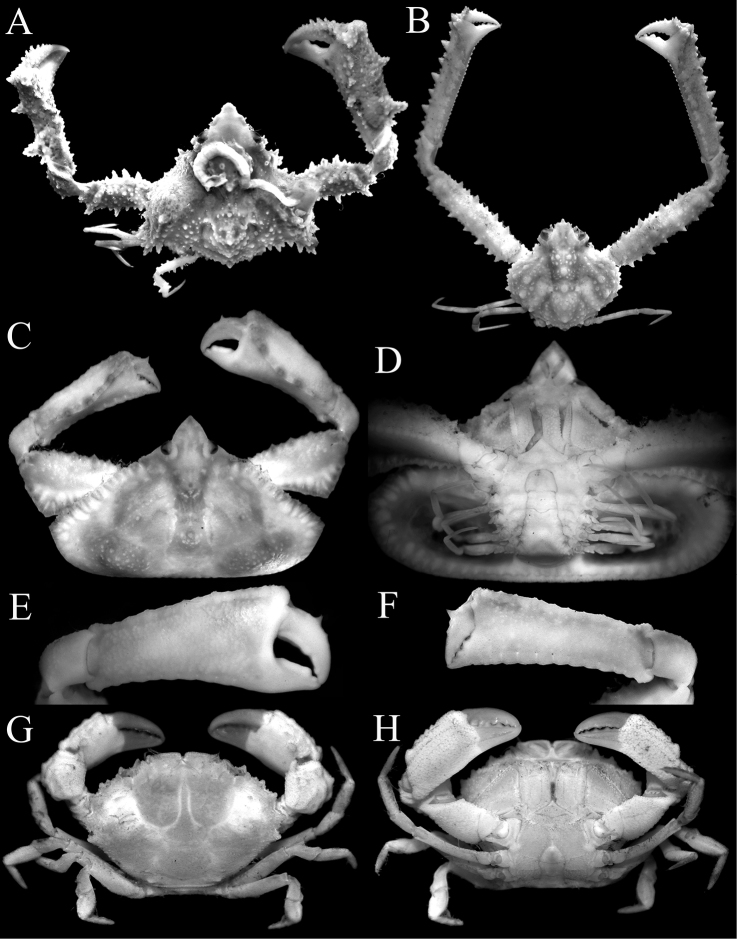
APseudolambrusbeaumonti (Alcock, 1895), female (9.4 × 8.8 mm) BRhinolambruscontrarius (Herbst, 1804), female (10.5 × 10.0 mm) C–FCryptopodiacollifer Flipse, 1930, male (17.5 × 10.6 mm) G, HParaxanthodescumatodes (MacGilchrist, 1905), male (8.3 × 5.5 mm). A, B, C, G, H overall dorsal habitus D ventral view of cephalothorax E, F outer view of chelae.